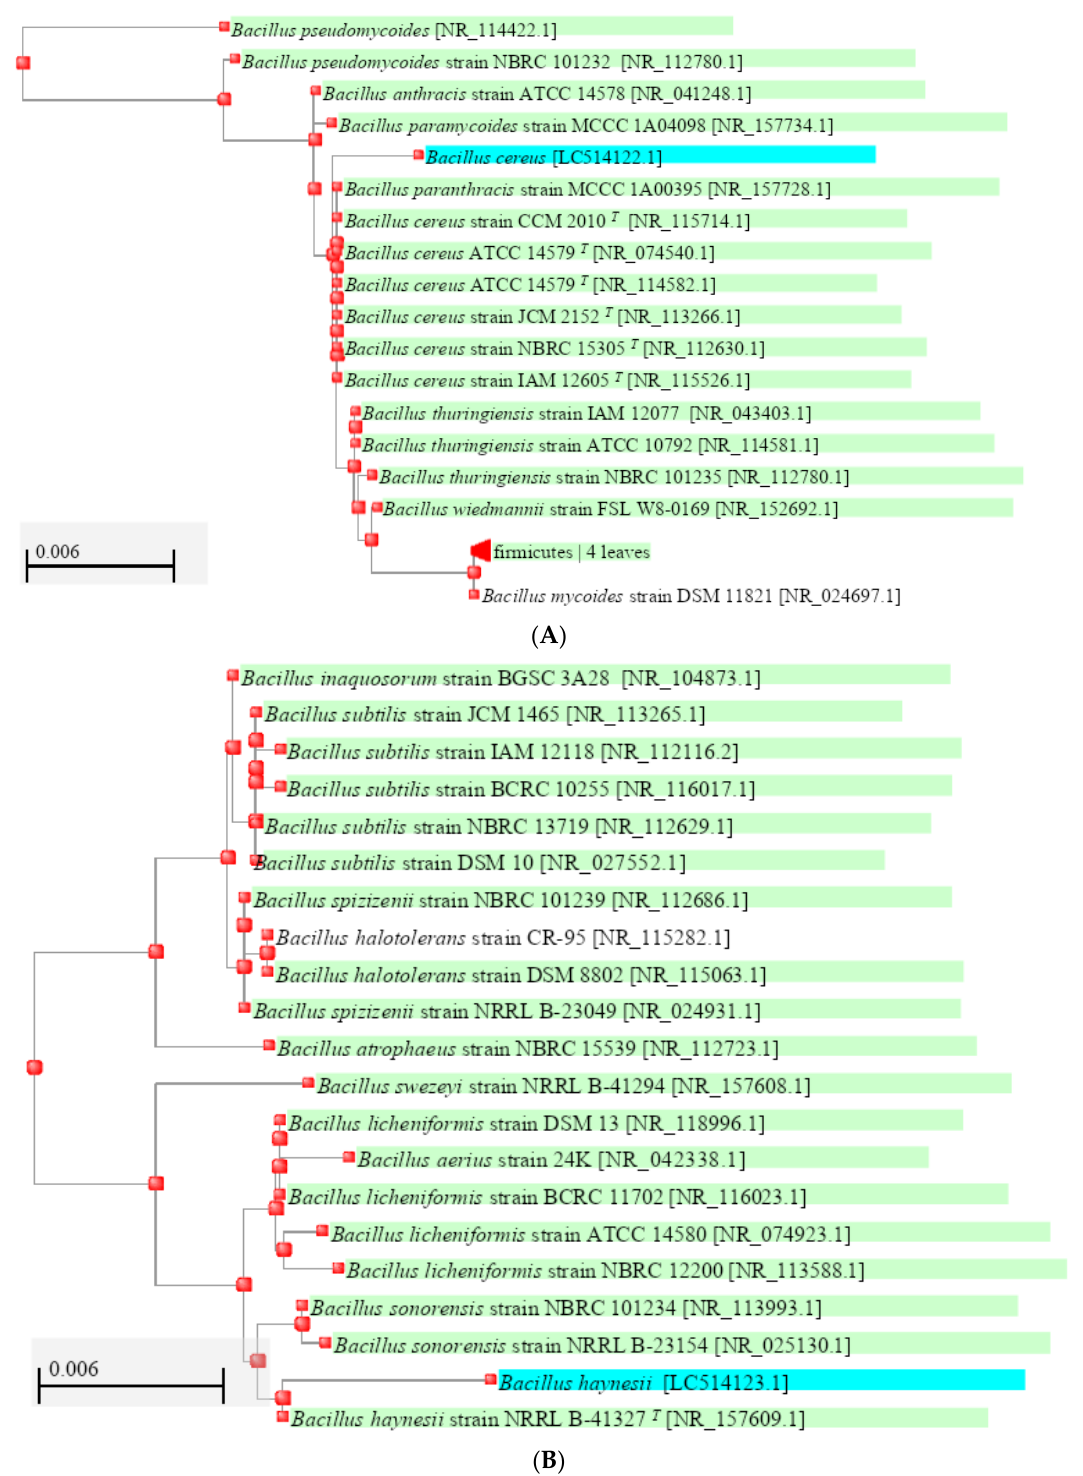
Figure 3. ( A ) Phylogenetic tree (NCBI BLAST): Tree Method used in constructing this picture was Fast minimum evolution with maximum sequence distance as 0.75. Sea-green-colour-indicated query ( Bacillus cereus ) was searched for 16S rRNA partial sequences from Bacteria and Archaea, bottle-green-colored strains are from type material, and red colour is an indication for Firmicutes. The Type strains are superscripted with T. ( B ) Phylogenetic tree (NCBI BLAST): Tree Method used in constructing this picture was Fast minimum evolution with maximum sequence distance as 0.75. Sea-green-colour-indicated query ( Bacillus haynesii ) was searched for 16S rRNA partial